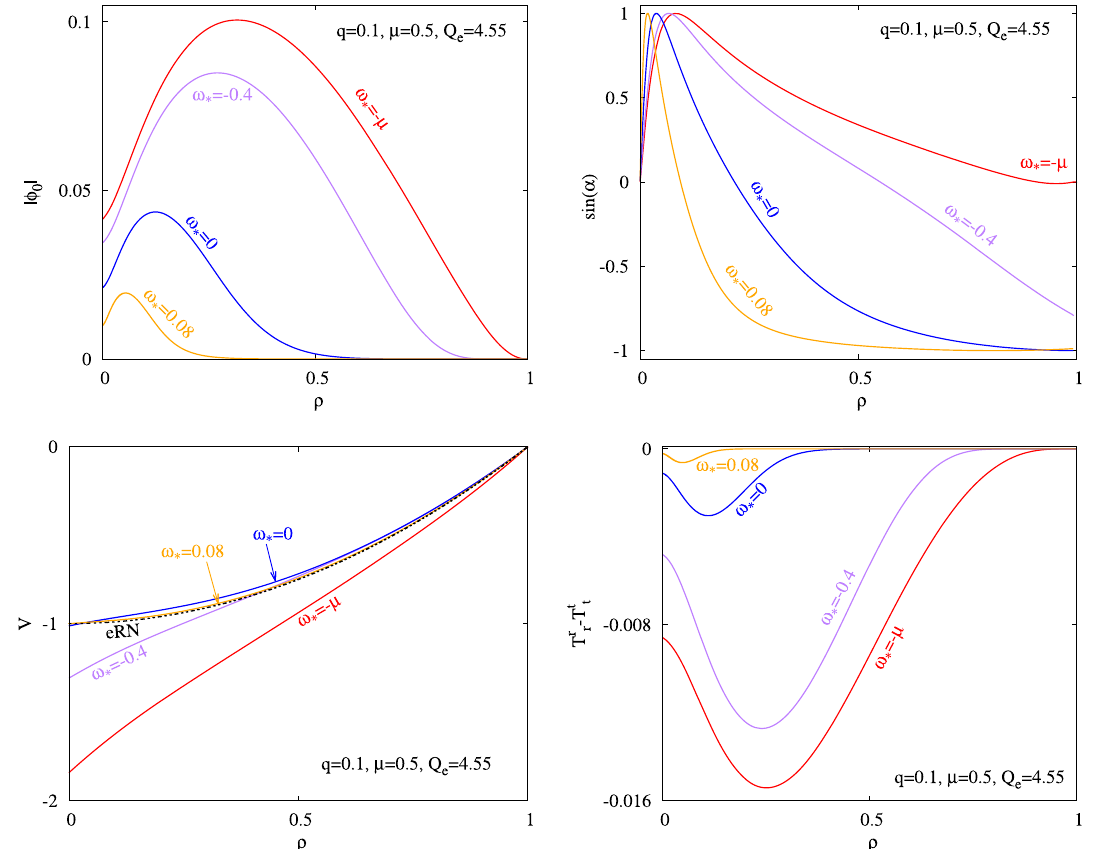
Fig. 2 Matter functions | φ 0 | (top left), sin (α) (top right), V (bottom left) and T r r − T t t (bottom right) versus the compactified coordinate ρ . Each color corresponds to a solution with w ∗ = {− μ, − 0 . 4 , 0 , 0 . 08 } (red, purple, blue and orange respectively). All solutions have q = 0 . 1, μ = 0 . 5, Q e = 4 . 55, κ =